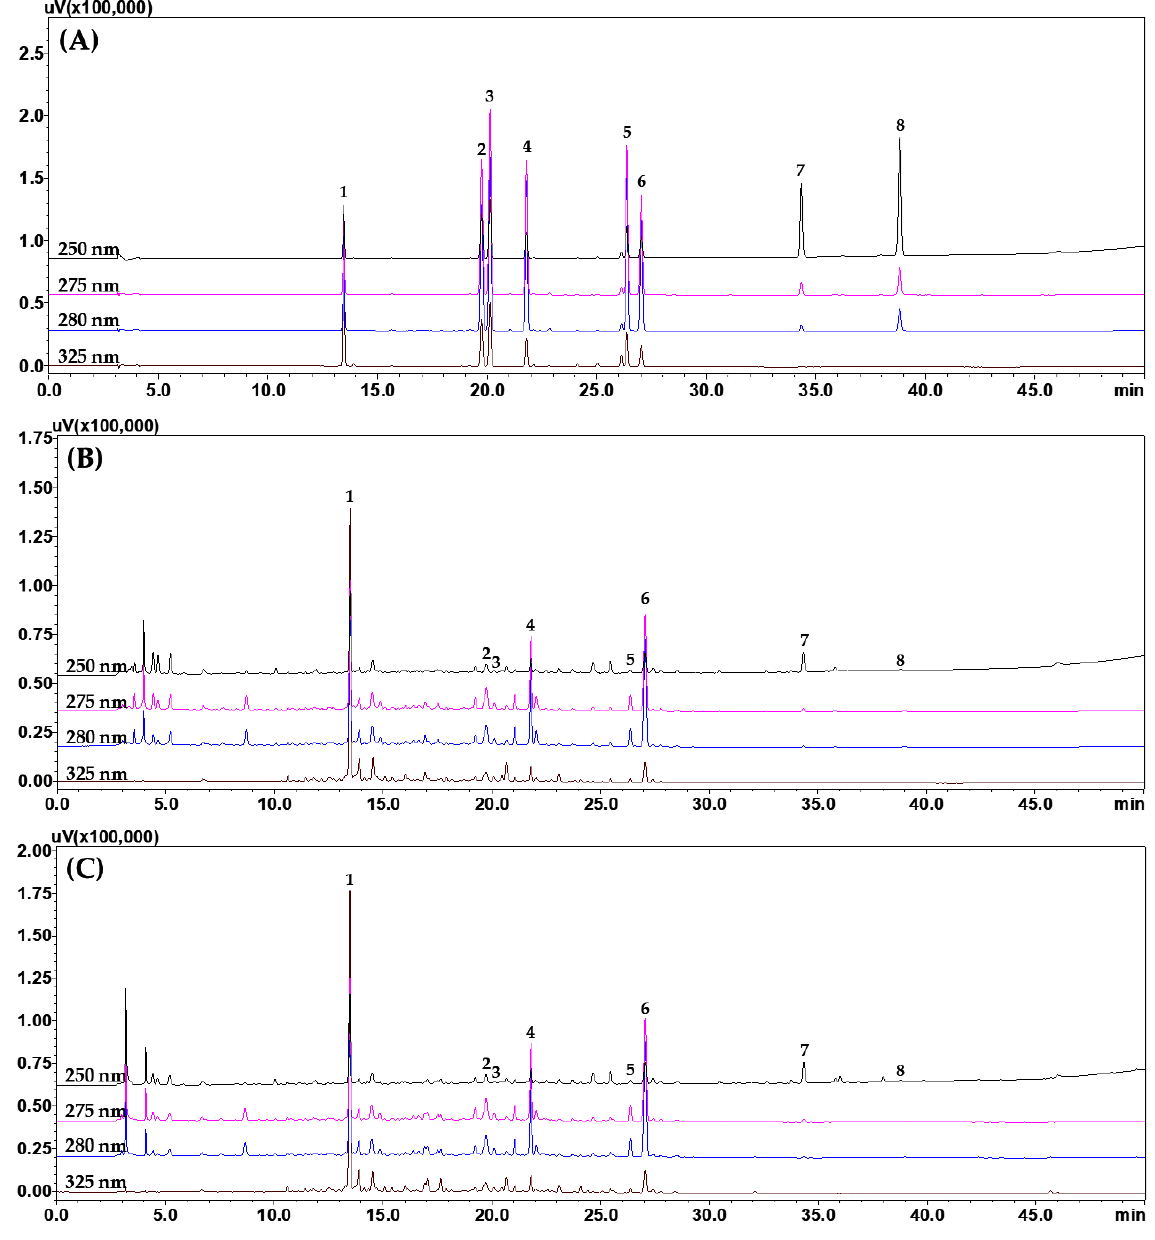
Figure 1. Typical HPLC chromatograms of ( A ) authentic standards, ( B ) ISYPT DW extract, and ( C ) ISYPT 70% MeOH extract of ISYPT samples at 250, 275, 280, and 325 nm. MBRSA ( 1 ), LQRTA ( 2 ), LQRTS ( 3 ), NRG ( 4 ), DDM ( 5 ), PCR ( 6 ), GCRZA ( 7 ), and SZDRA ( 8 ).